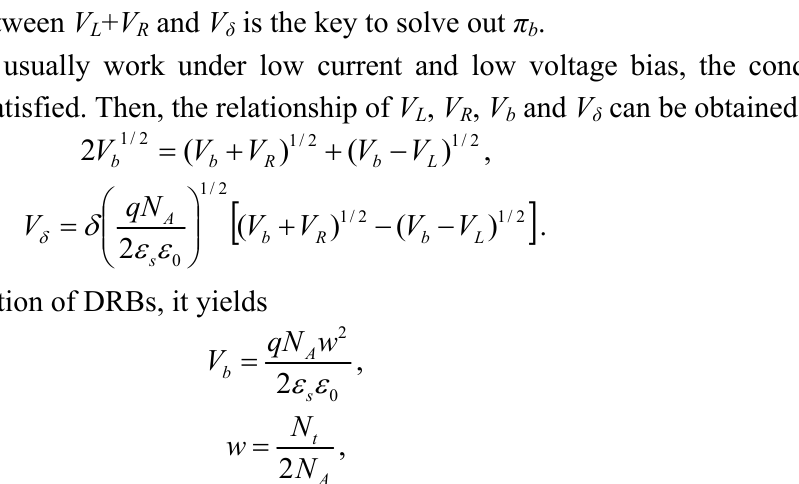
. The trap density N A